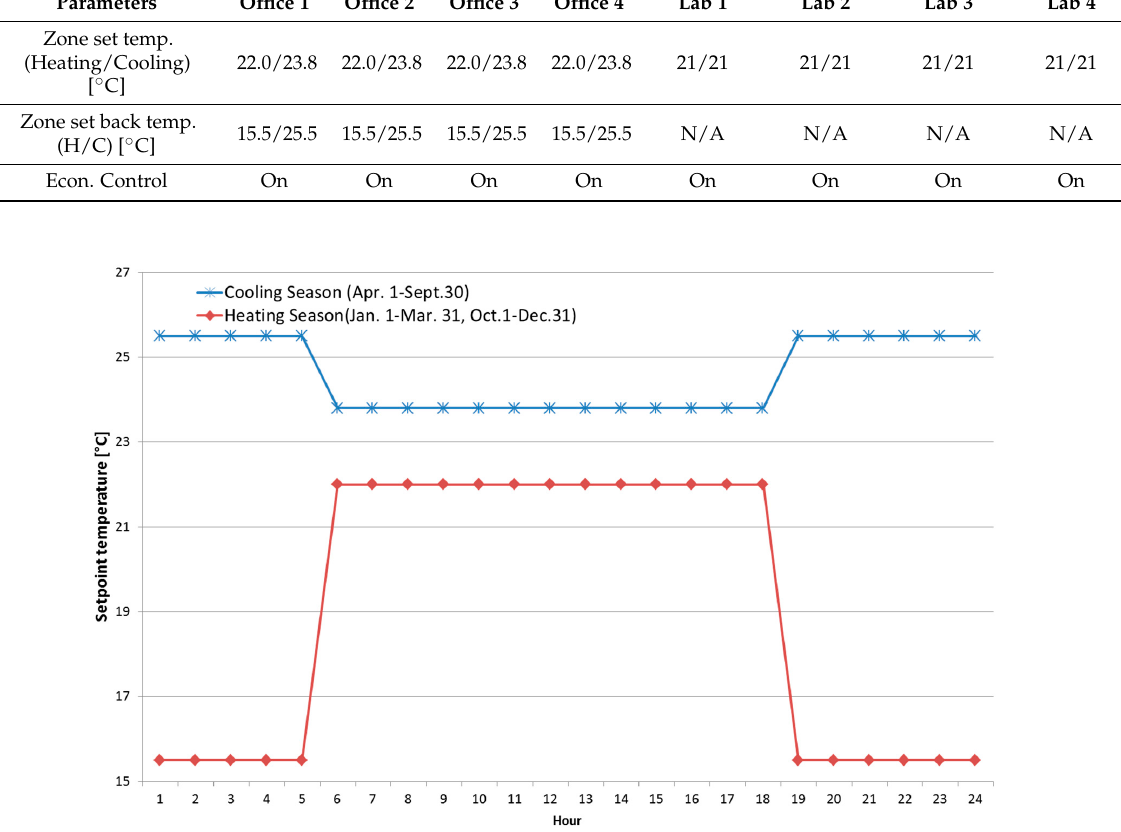
Figure 3. Setpoint temperature profiles for office space.